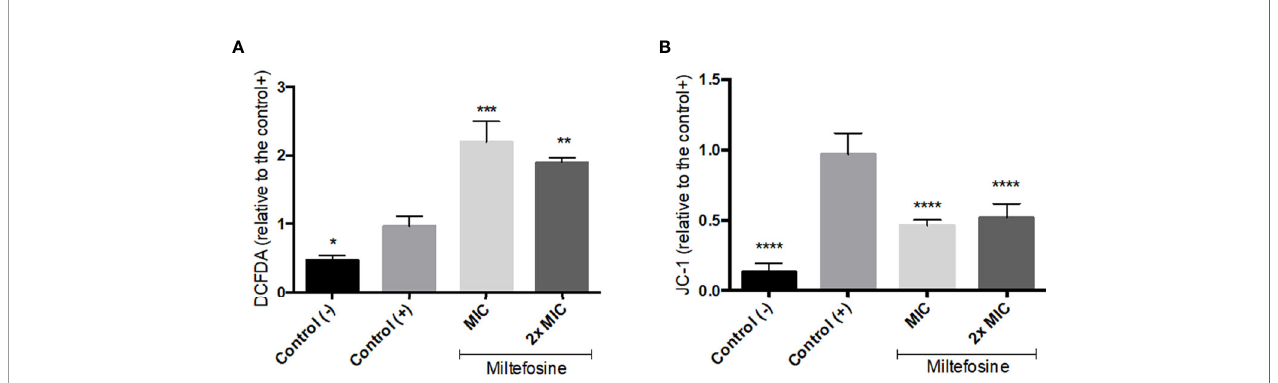
FIGURE 6 | The effect of miltefosine on oxidative stress (A) and the mitochondrial membrane potential (B) in Scedosporium aurantiacum after 6 h of incubation. DCFH-DA and JC-1 fl uorescent staining was used to measure reactive oxygen species (ROS) production and membrane polarisation, respectively. Control (-) represents cells in the absence of fl uorescent stain. Control (+) represents cells stained with fl uorescent DCFDA or JC-1, but without miltefosine treatment. * p < 0.05, ** p < 0.01, *** p < 0.001, **** p < 0.0001.